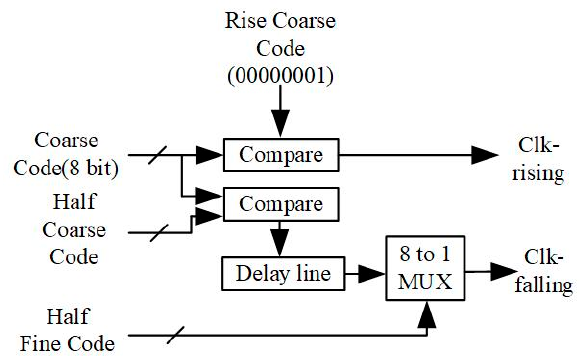
Figure 6. The block diagram.